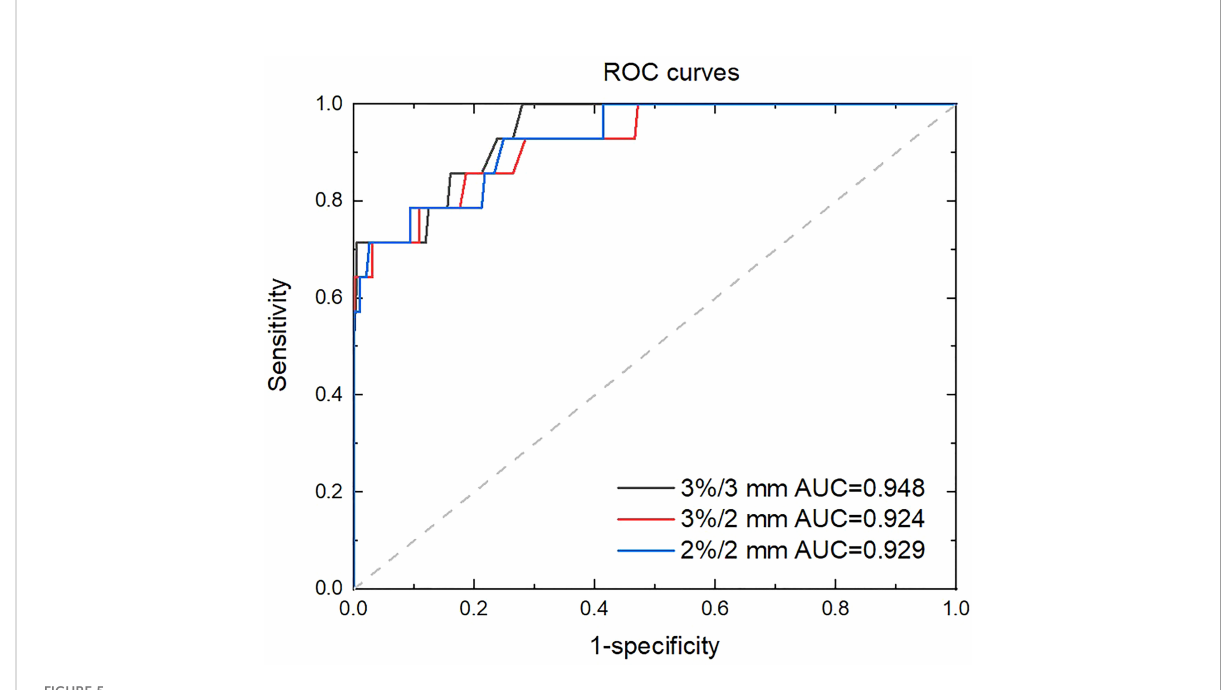
FIGURE 5 ROC curves with varying criterion of MC